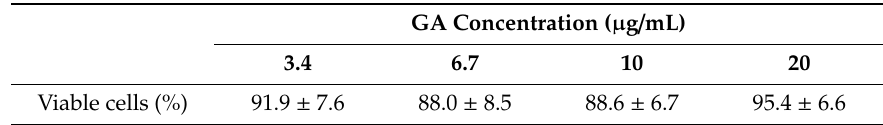
Table 2. Cell viability of 3T3 cells after culture with di ff erent concentrations of GA for 24 h. Results are shown in mean percentage respect to the controls taken as 100% (mean ± SD, n =